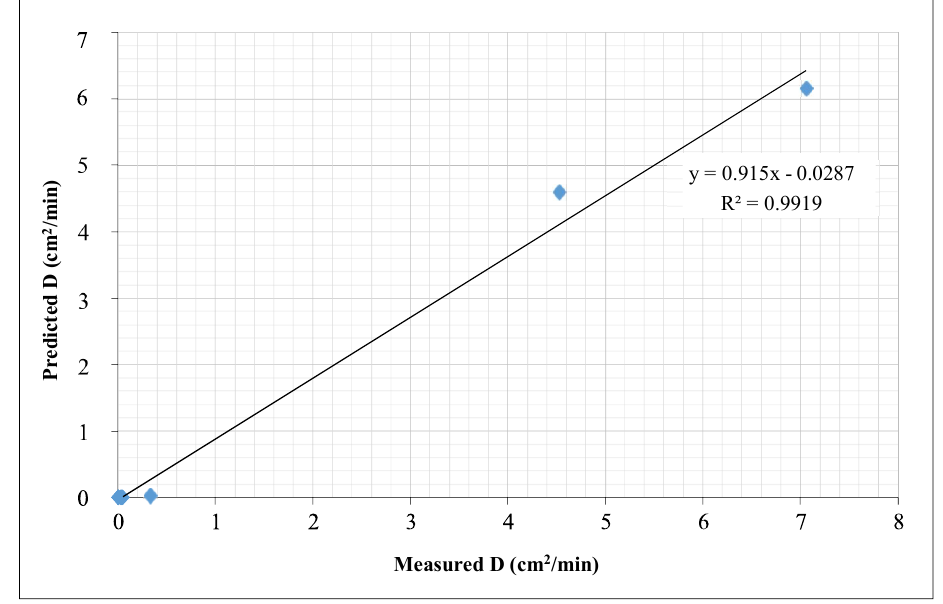
Figure 3. Verification of graph showing predicted and measured of dispersion in soil.